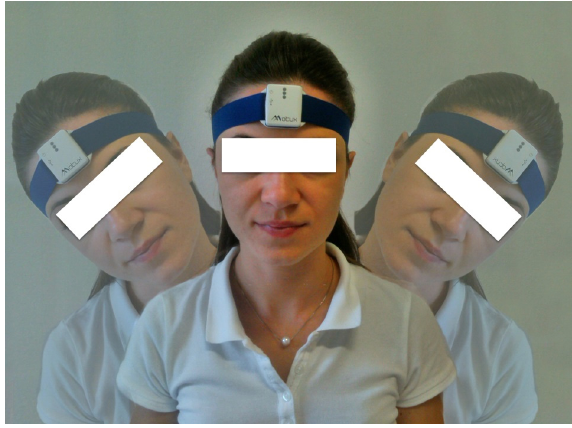
Figure 1. Position of the IIS and execution of lateral flexion.